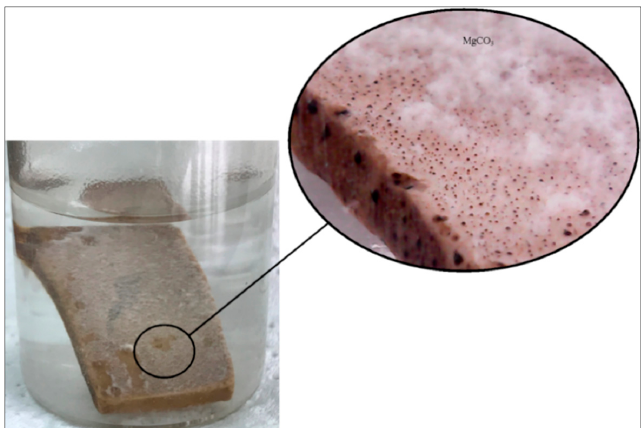
Figure 16. Precipitation of magnesite during the experiments.